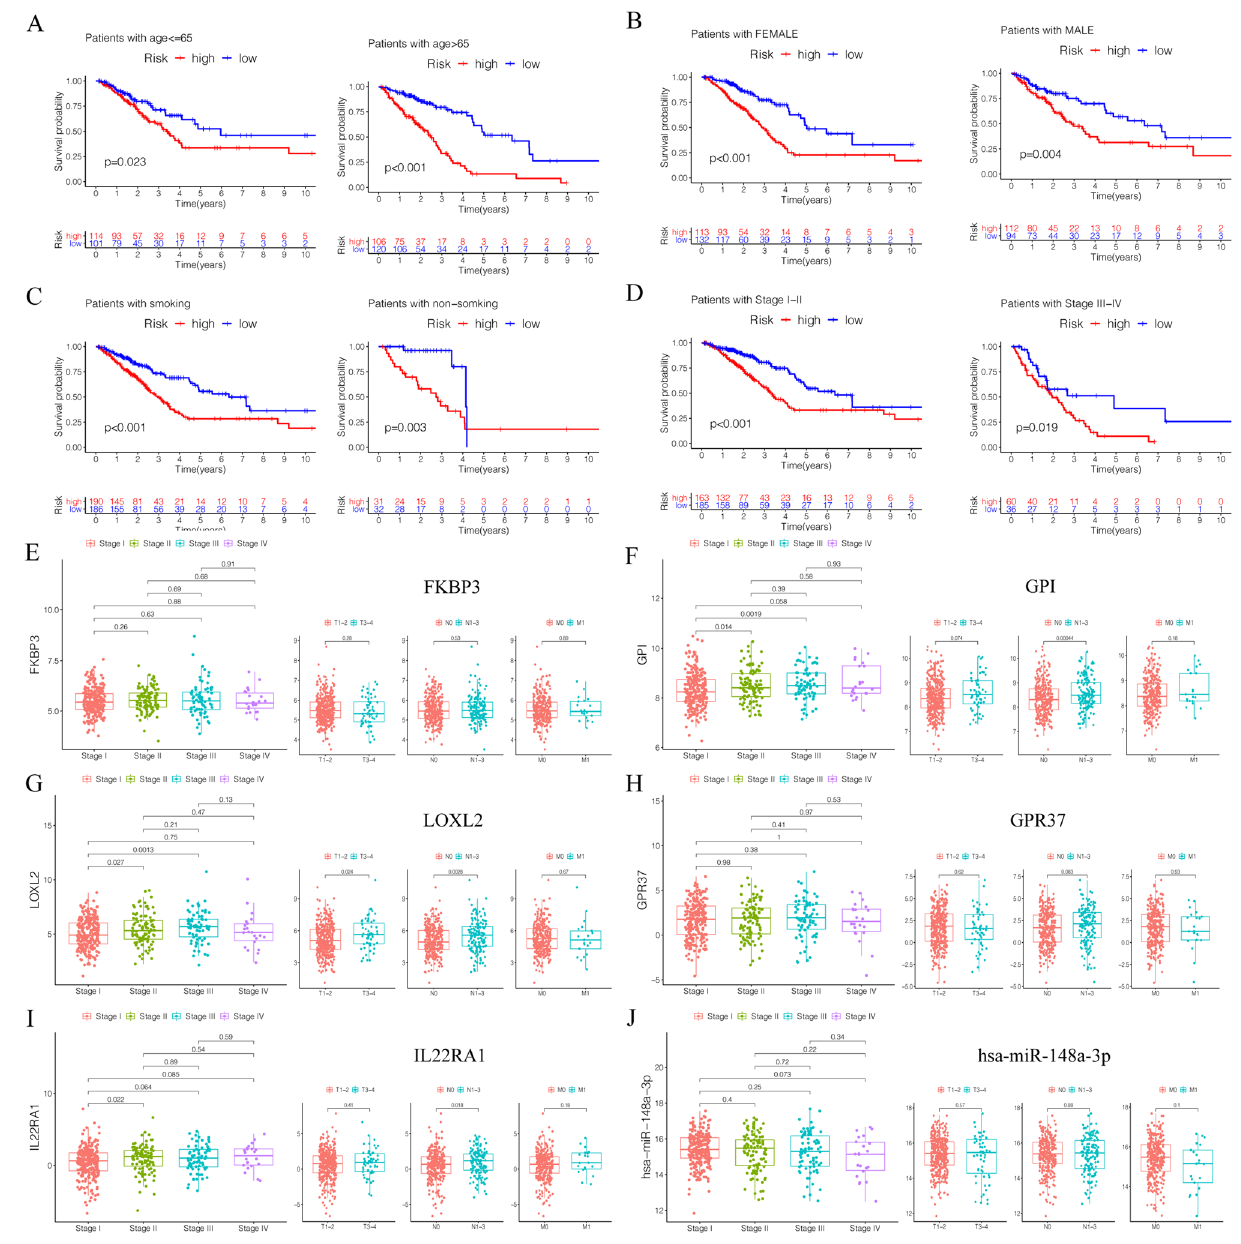
Figure 5. Subgroup analysis classified by patients’ age ( A ), gender ( B ), smoking status ( C ) and clinic stage ( D ) were conducted. ( E – J ) The expression of the 6 key genes ( FKBP3, GPI, LOXL2, IL22RA1, GPR37 , has-miR- 148a-3p ) in lung adenocarcinoma patients with different tumor stages, T stages, N stages and M